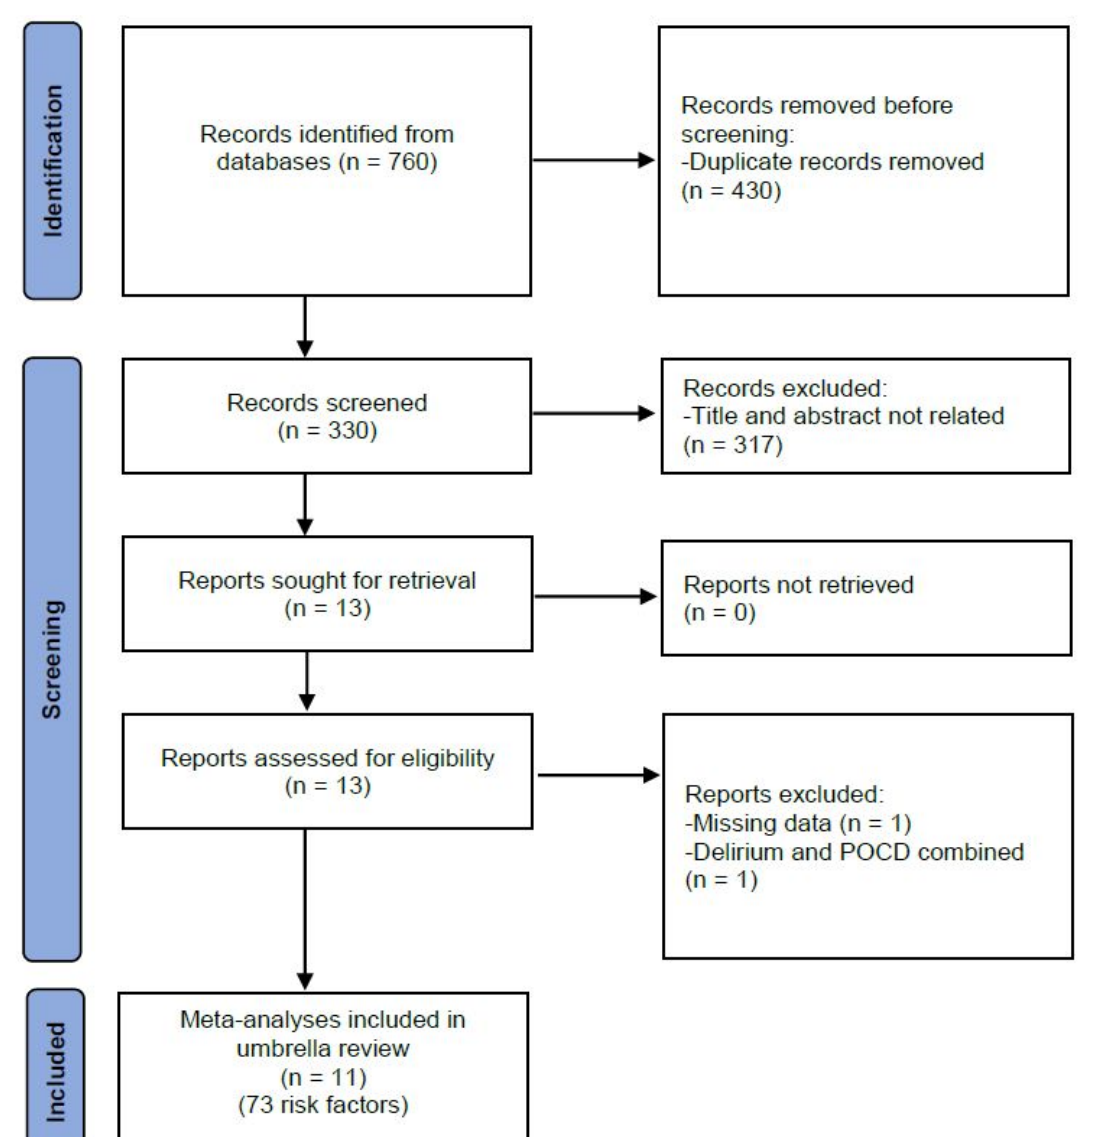
Figure 1. PRISMA flow chart of study selection. Legend: POCD = post-operative cognitive dysfunc- tion.